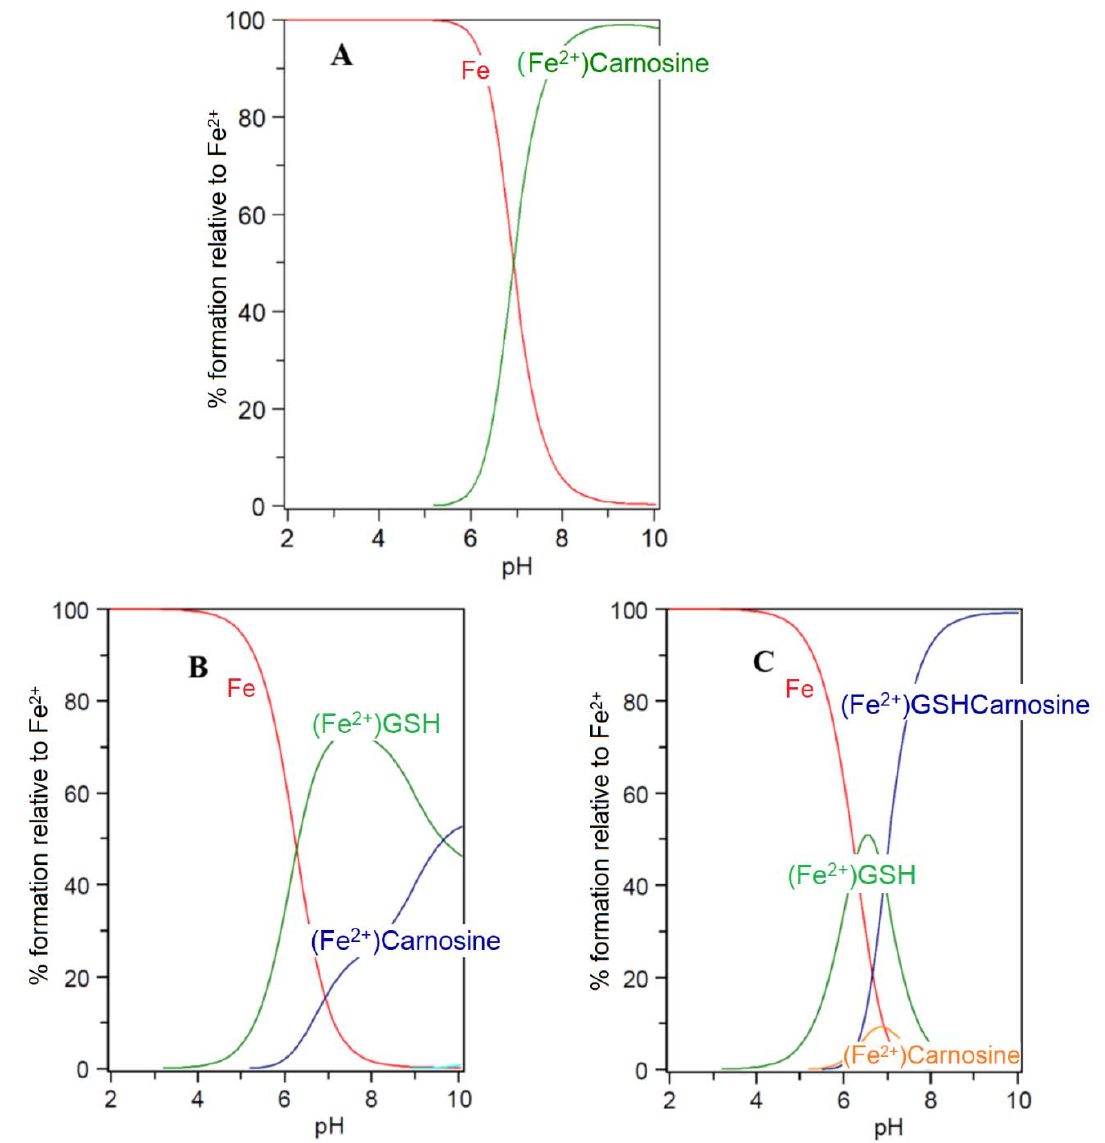
Figure 6. Speciation plots of carnosine with Fe(II) in the presence and absence of glutathione (GSH): ( A ) carnosine (10 mM), Fe 2+ (1 µ M); ( B ) carnosine (10 mM), Fe 2+ (1 µ M), GSH (2 mM); and ( C ) carnosine (10 mM), Fe 2+ (1 µ M), GSH (2 mM) with the formation of the ternary complex assumed to be possible. Log K Fe(II)-GSH = 5.1; Log K Fe(II)-carnosine = 4.5; Log K Fe(II)-GSH-carnosine = 9.6.